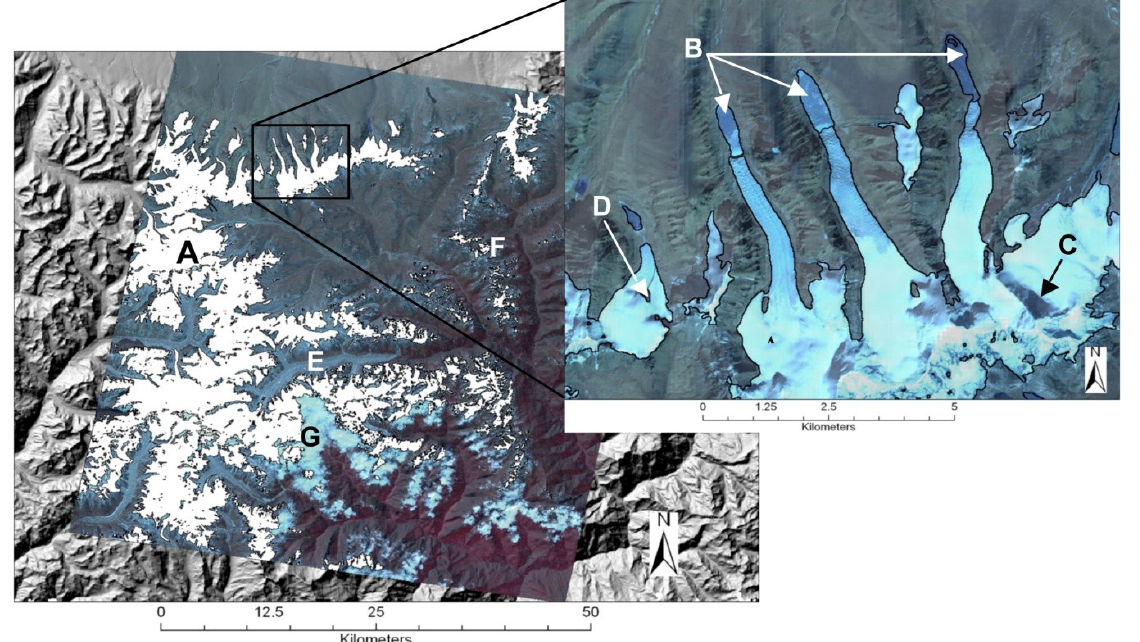
Figure 5. Results of the clean ice/snow delineation based on the 2001 ASTER scene, using the NDSI algorithm. The letters point to: A-correctly classified clean ice and snow; B-proglacial lakes misclassified as snow/ice; C-shadows on glacier surface; D-nunataks; E-debris covered tongue of Zemu glacier, missed by the NDSI algorithm; F-transient snow misclassified as glacier ice and G- clouds. Adapted from Racoviteanu et al.